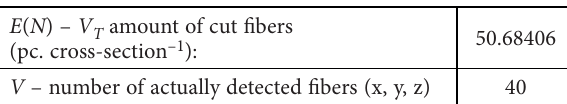
Table 4. Statistical estimate of cut fibers